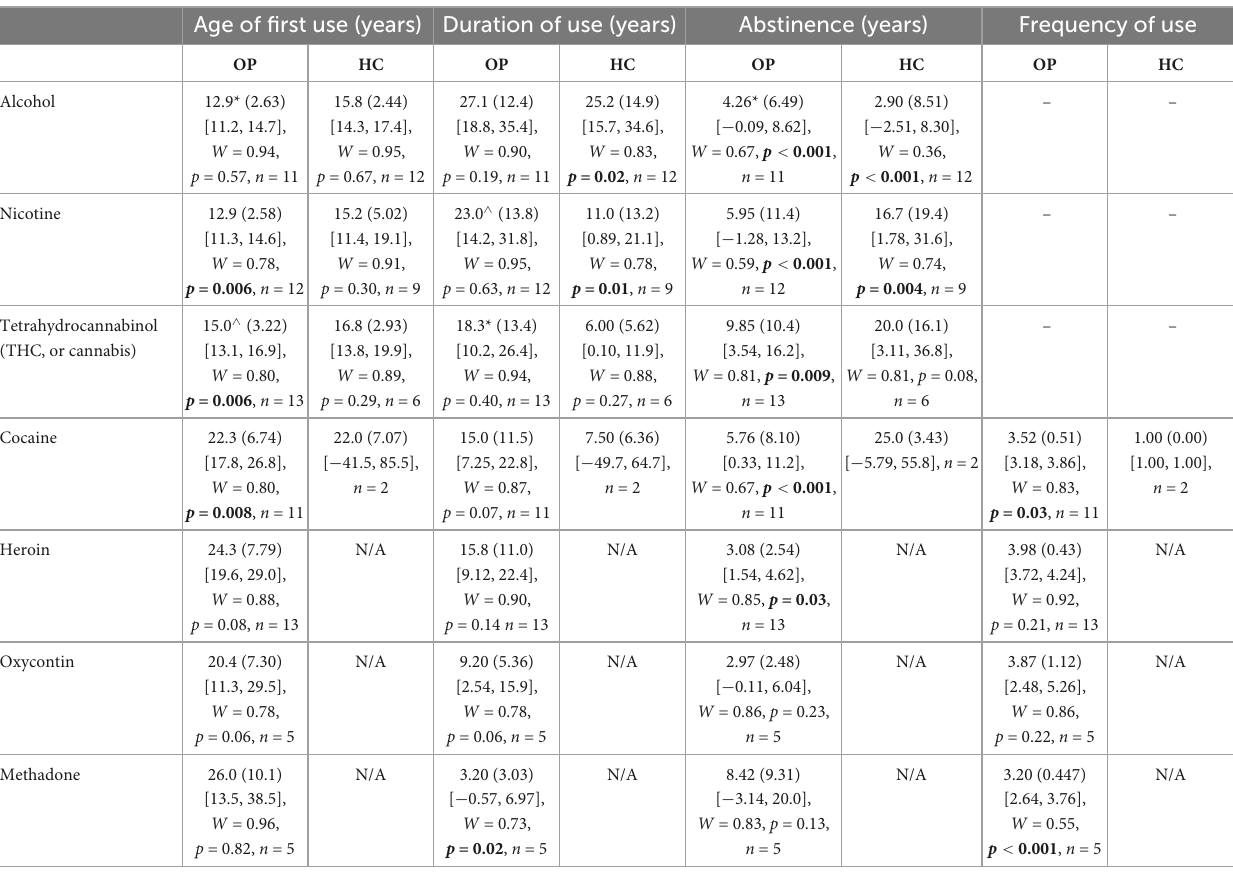
TABLE 2 Drug history by